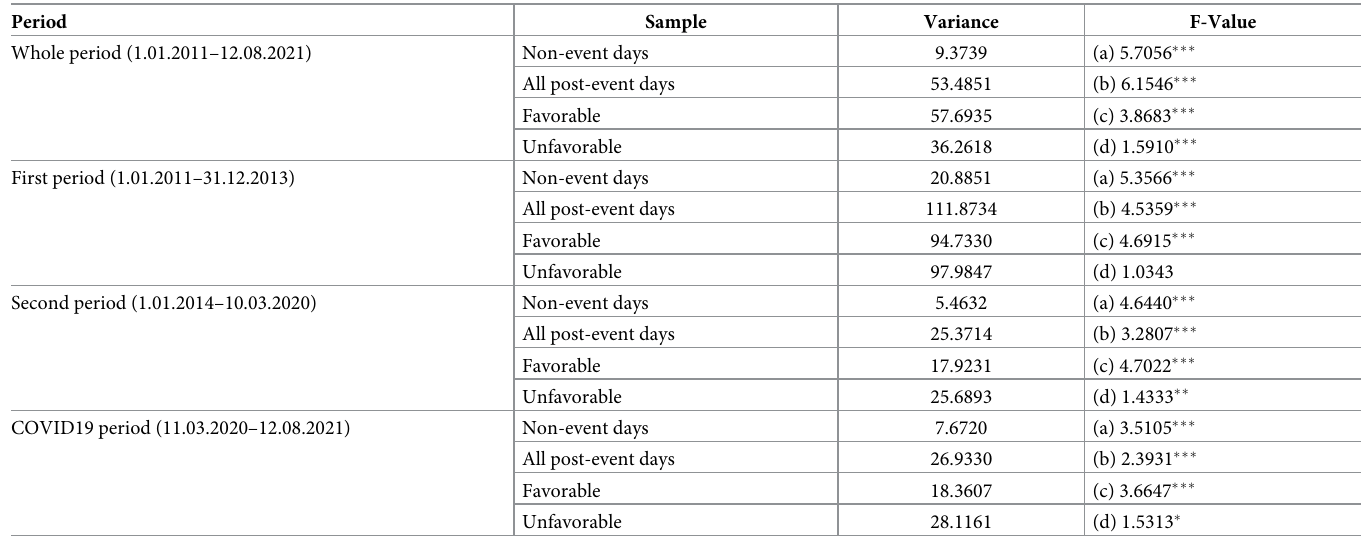
Table 3. Variance of returns and F-test for Bitcoin.